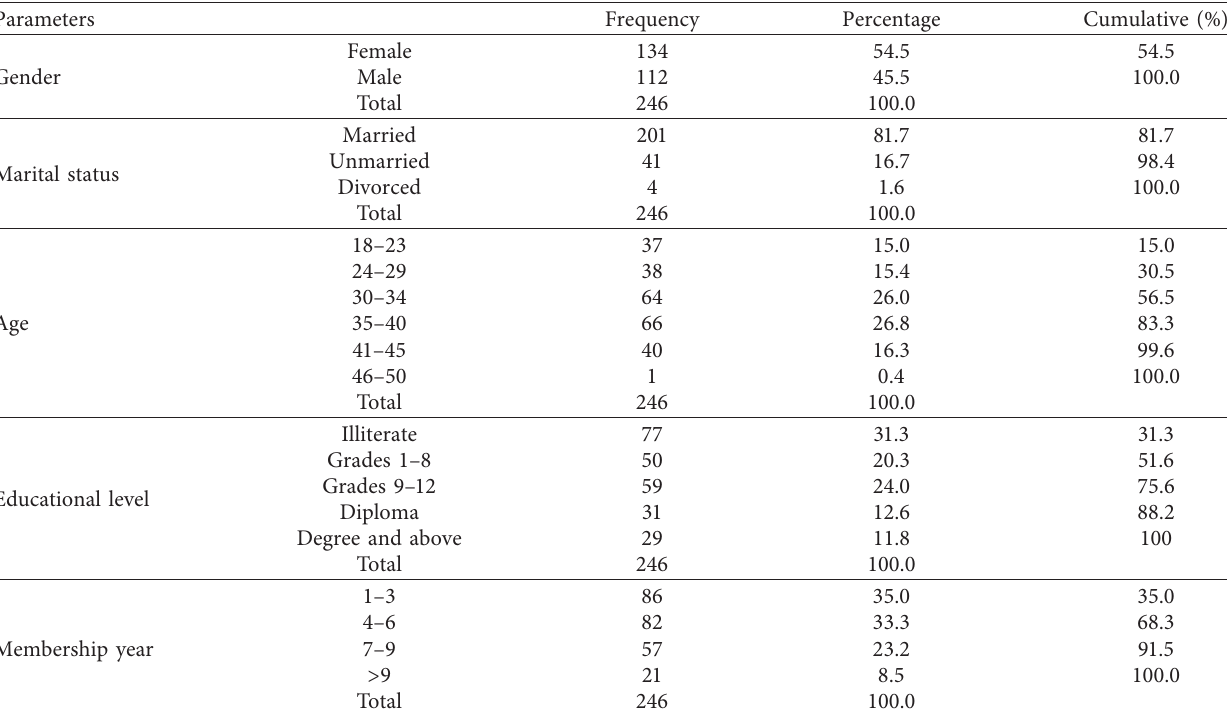
Table 2: Demographic characteristics of the respondents.